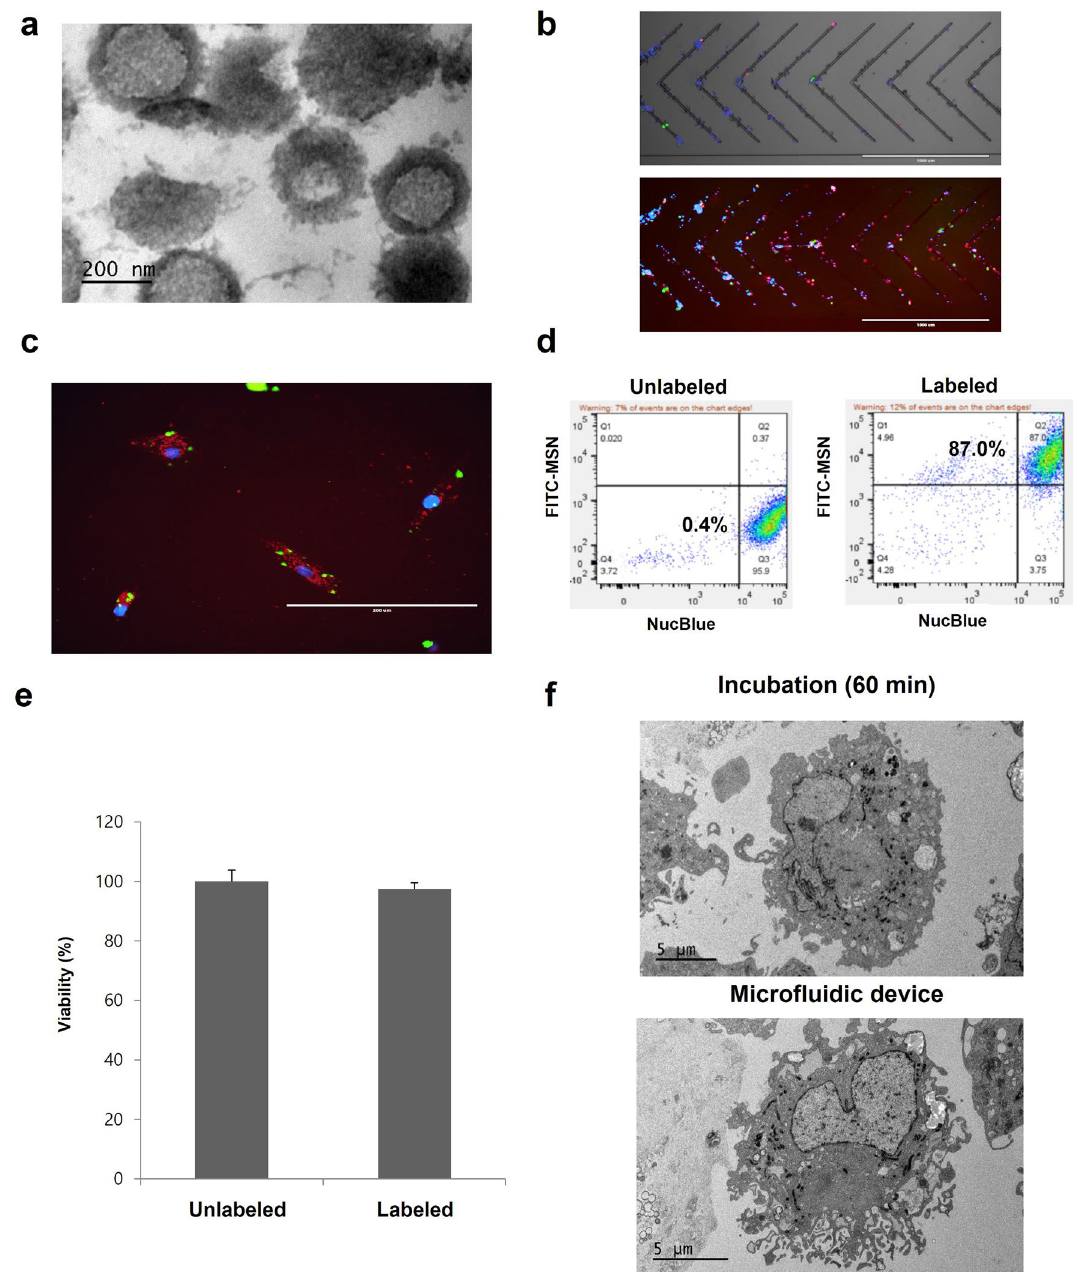
(green:FITC; blue:nucleus; red: cell membrane). ( c ) FITC-MSNs were efficiently transported into ADSCs. ( d ) FACS analysis showing that labeled cells have higher green fluorescence than unlabeled cells. ( e ) CCK viability found no significant difference between unlabeled and labeled cells. ( f ) TEM images showing cellular uptake of MSNs in ADSCs after passive incubation (60 min) and microfluidic mechanoporation (0.5